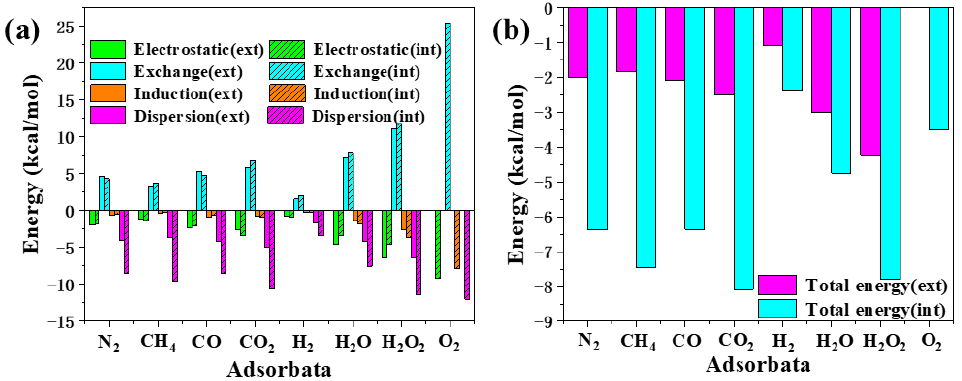
Figure 6. The energy of different physical components ( a ) and total energy ( b ) of the interaction between [6, 6]CNB and small molecules based on SAPT energy decomposition, in kcal/mol. First of all, it was necessary to analyze the total energy of the interaction. The total en- ergy can directly reflect the strength of adsorption between [6, 6] CNB and small molecules.